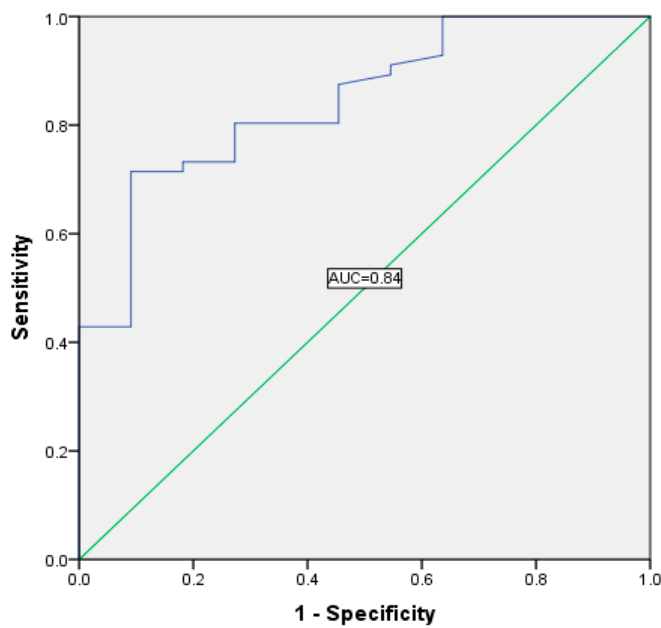
Figure 3. Receiver operating characteristic (ROC) curve for HRRI as a predictor of susceptibility to CRT response: area under the ROC = 0.844 for a value of HRRI = 1.51 representing cutoff point (sensitivity 80%; specificity 80%, p < 0.001).